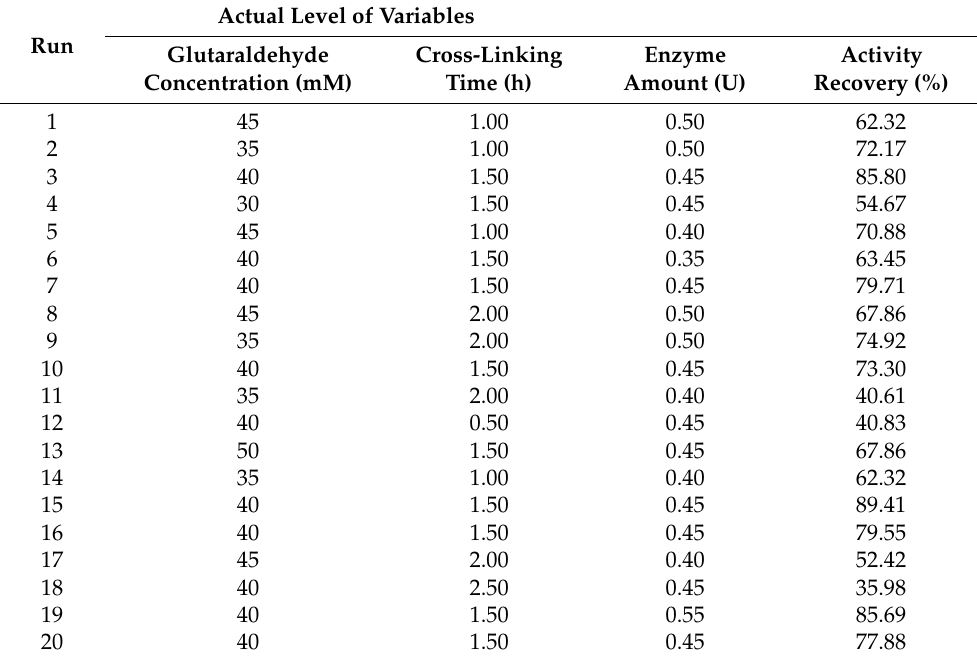
Table 1. Experimental design and results of the central composite design. Actual Level of Variables Run